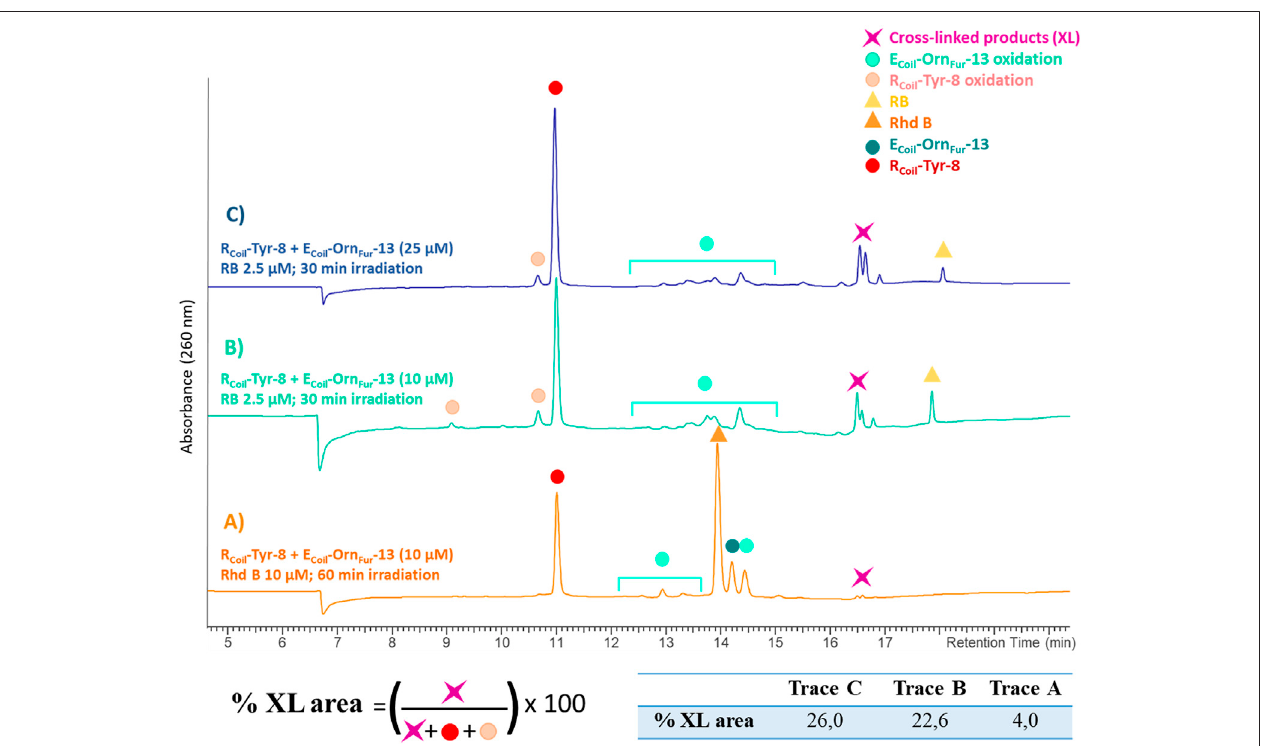
FIGURE 9 | All chromatograms show the cross-link reaction product (purple star) between R Coil -Tyr-8 (red dot) and E Coil -Orn Fur -13 (dark green dot) after light irradiation withRhdB(orange triangle) andRB(yellow triangle). TheE Coil -Orn Fur -13oxidationproducts (green lightdots) areproduced after activationofthefuran moiety bysingletoxygengeneration. (A) R Coil -Tyr-8(10 μ M)andE Coil -Orn Fur -13(10 μ M),RhdB10 μ Mand60 minoflightirradiation. (B) R Coil -Tyr-8(10 μ M)andE Coil -Orn Fur -13 (10 μ M),RB2.5 μ Mand30 minoflightirradiation. (C) R Coil -Tyr-8(25 μ M)andE Coil -Orn Fur -13(25 μ M),RB2.5 μ Mand30 minoflightirradiation.Thecross-linkyield was quanti fi ed as the percentage of the cross-linked product area and the values are indicated in the table.